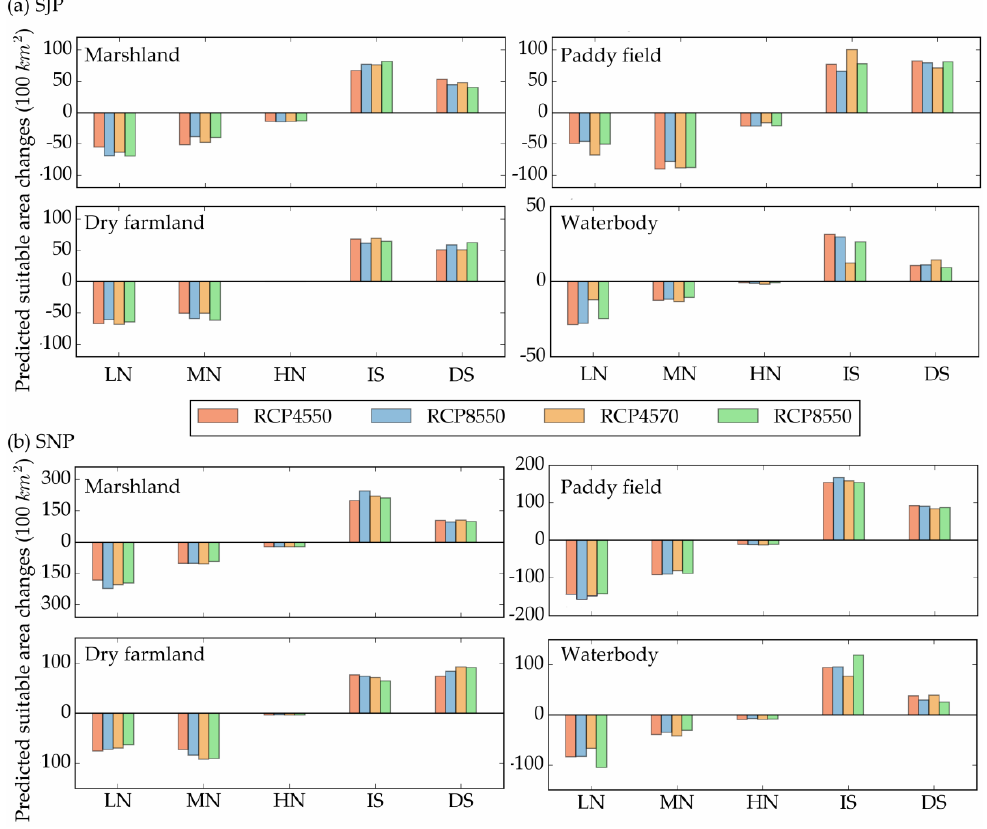
Figure 9. Predicted suitable area changes for marshland, paddy field, dry farmland and waterbody under the four future climatic scenarios over the ( a ) SJP and ( b ) SNP relative to the “current” baseline. Note: LN, low suitable/no change; MN, medium suitable/no change; HM, high suitable/no Change; IS, increasing suitability; DS, decreasing suitability.